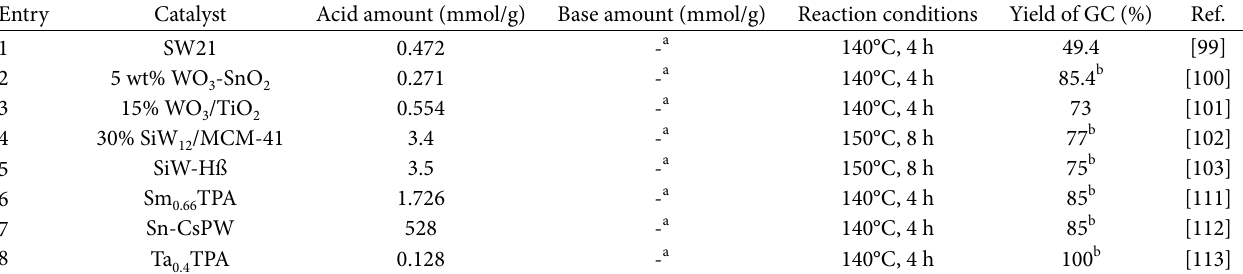
Scheme 9: Proposed reaction mechanism using Sm Table 3: Catalytic glycerolysis of urea to GC using tungsten-based